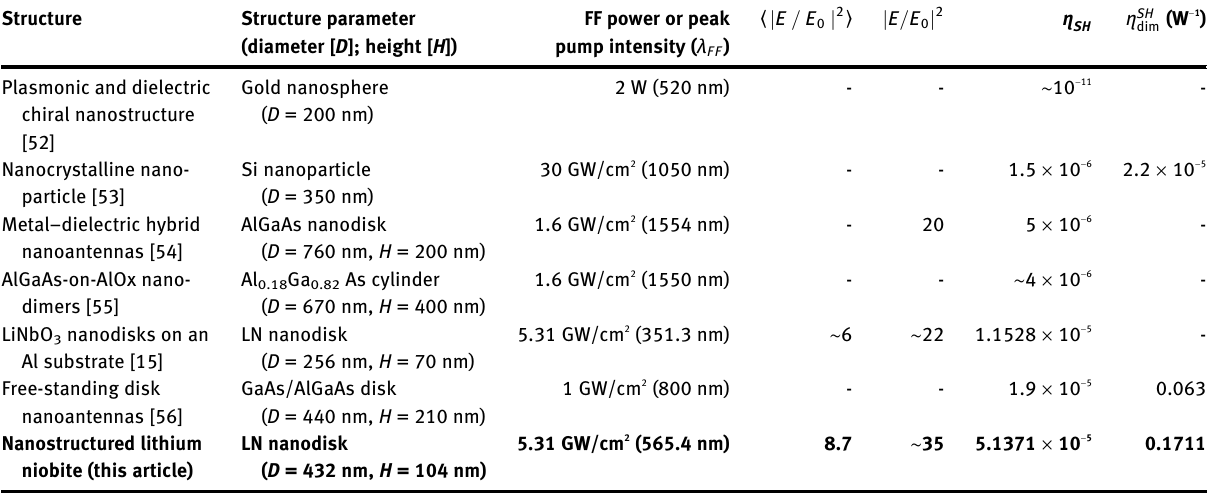
Table  : Comparisons of the electric- fi eld enhancement and SHG conversion ef fi ciency of different structures.